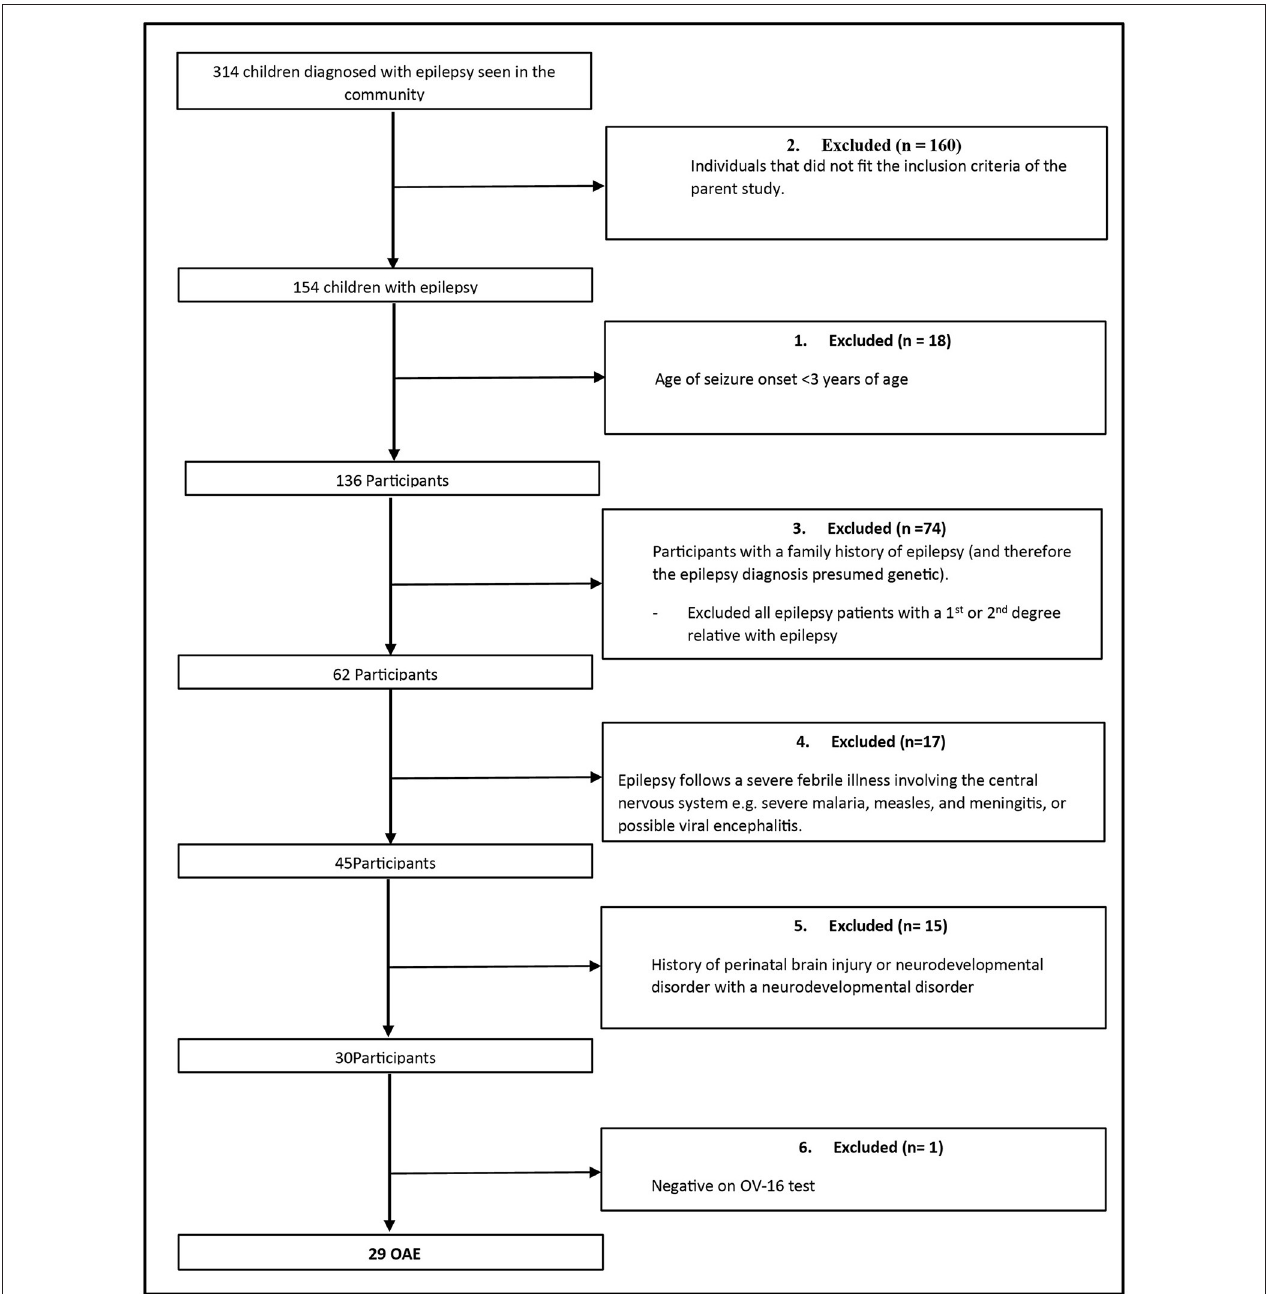
FIGURE 1 | Participant